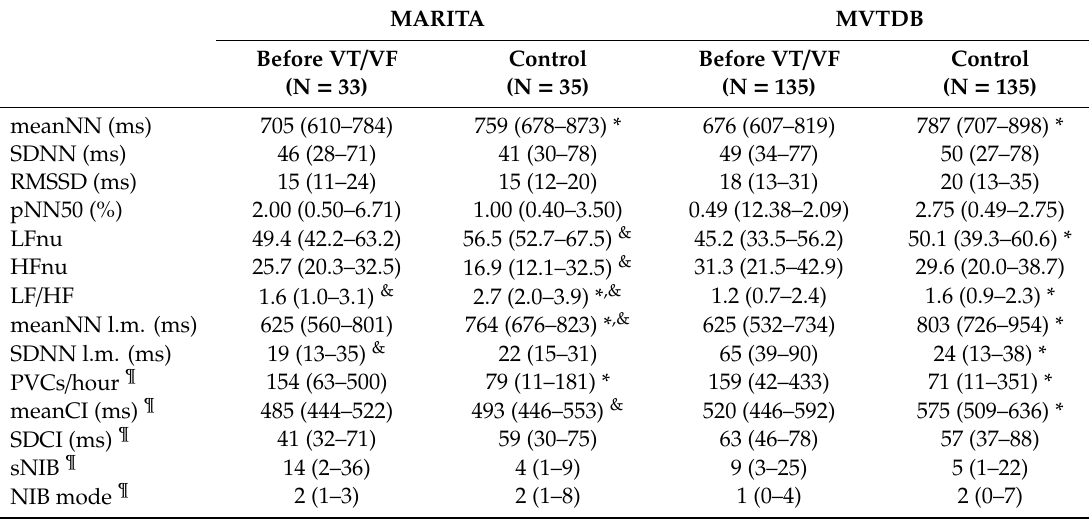
Table 2. Heart rate variability and heartprint indices evaluated from recordings before tachyarrhythmia (ventricular tachycardia (VT) / ventricular fibrillation (VF)) or control recordings for both datasets. Data are shown as medians (25th percentile–75th percentile).